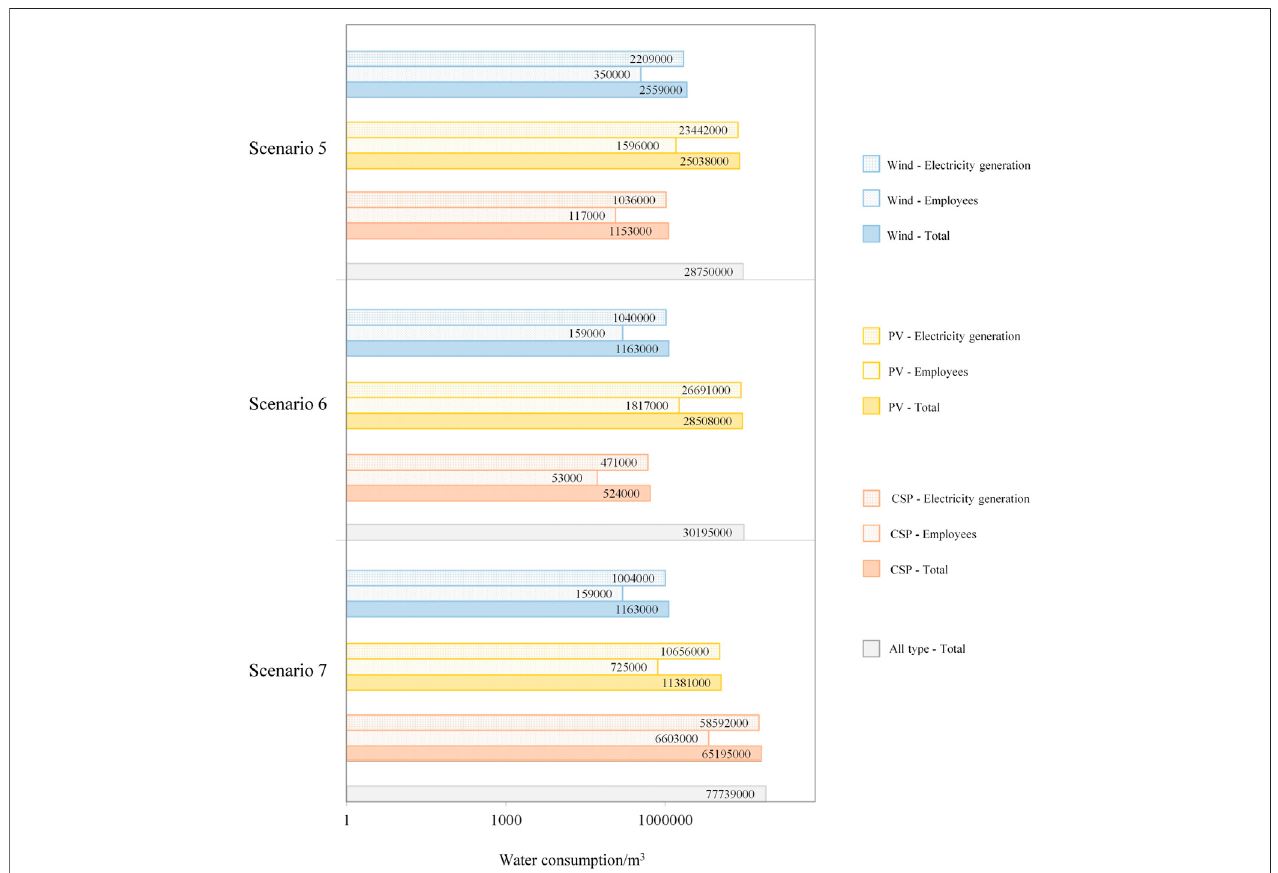
FIGURE 5 | Water consumption by renewable energy enterprises in Golmud under future